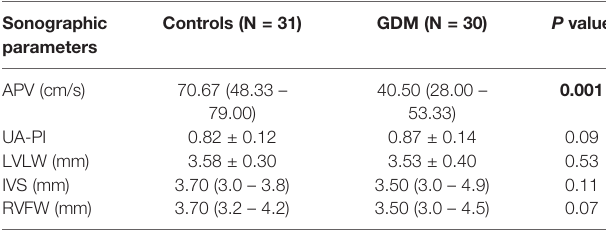
TABLE 2 | Comparison of sonographic parameters in fetuses from control and GDM